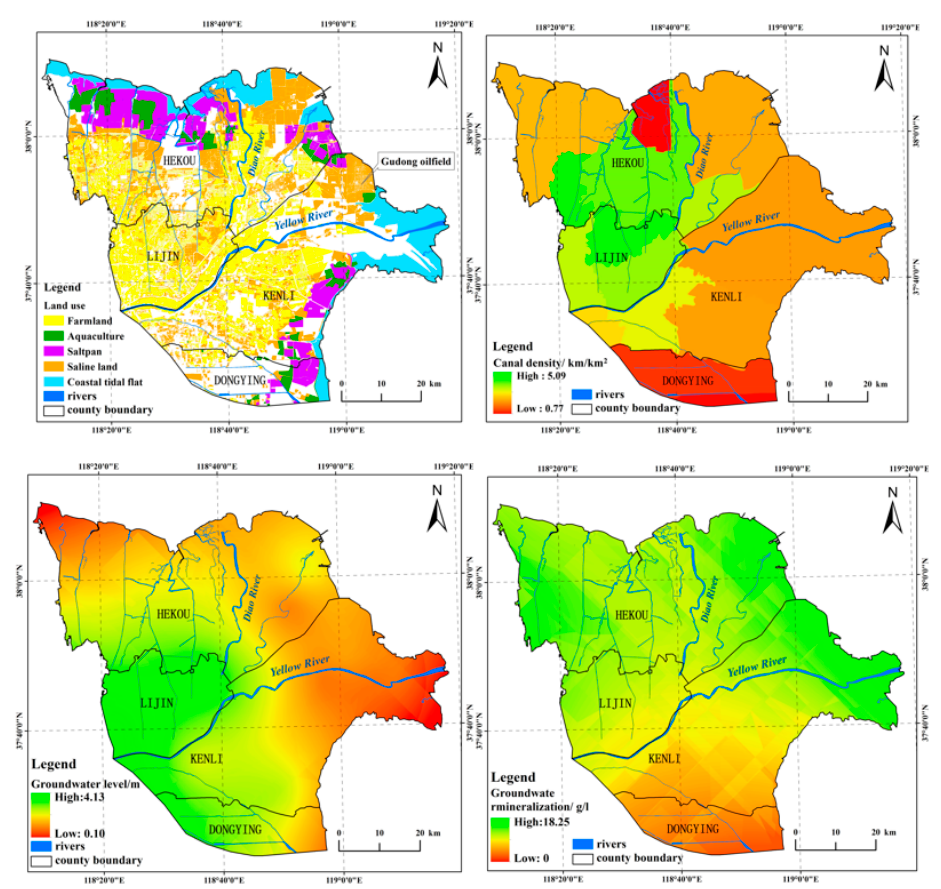
Figure 4. Spatial distributions of main land-use status and groundwater status in study area.